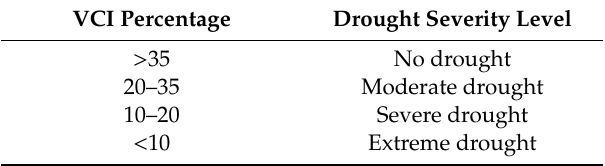
Table 2. Drought categories derived from the Vegetation Condition Index